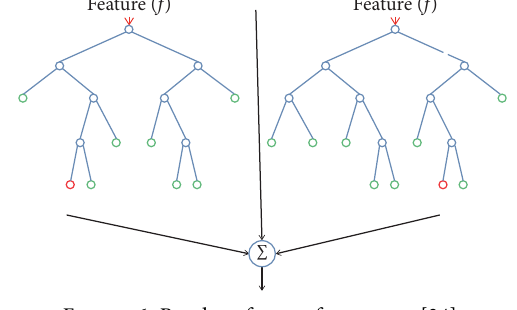
Figure 6: Random forest of two trees [24].